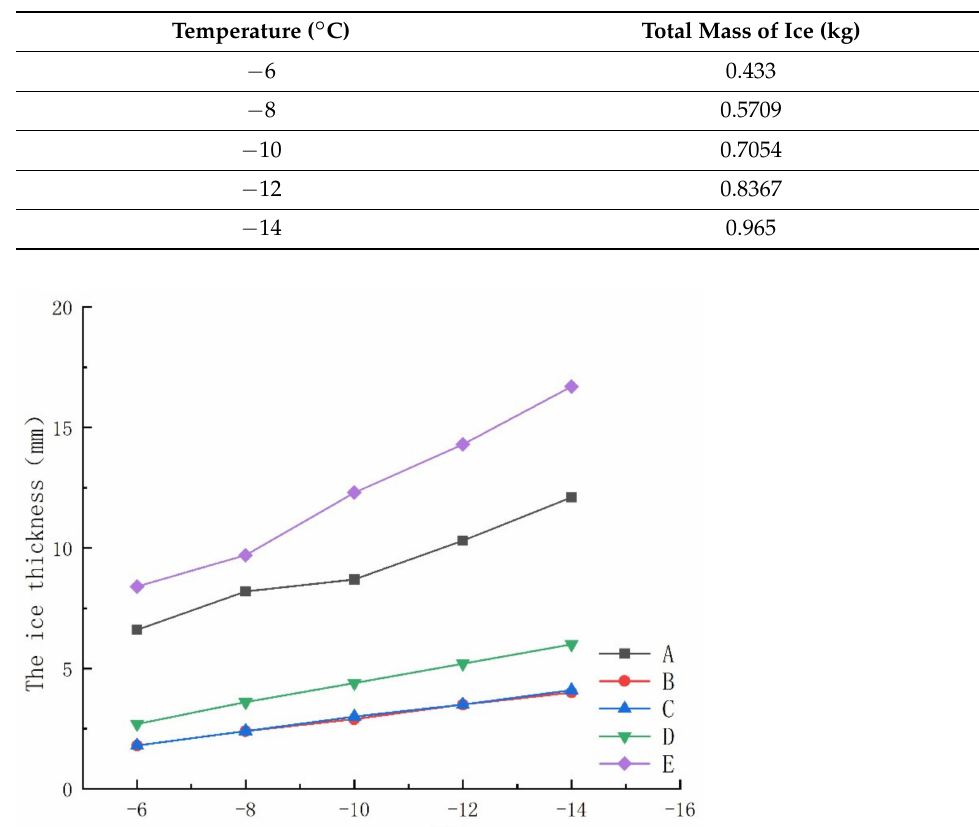
Table 2. Total mass of ice on cross beam surface at different temperature.